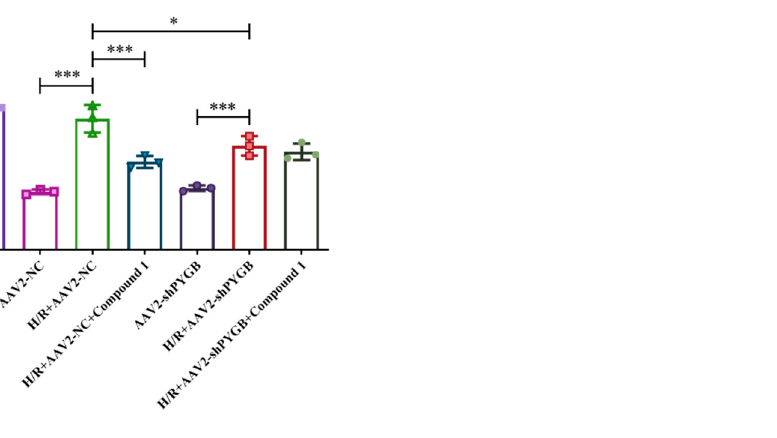
Figure 4. Effect of compound 1 on post-ischemic intracellular ATP content after PYGB knockdown. Data represent mean ± SD (* p < 0.05 *** p < 0.001; ### p < 0.001).